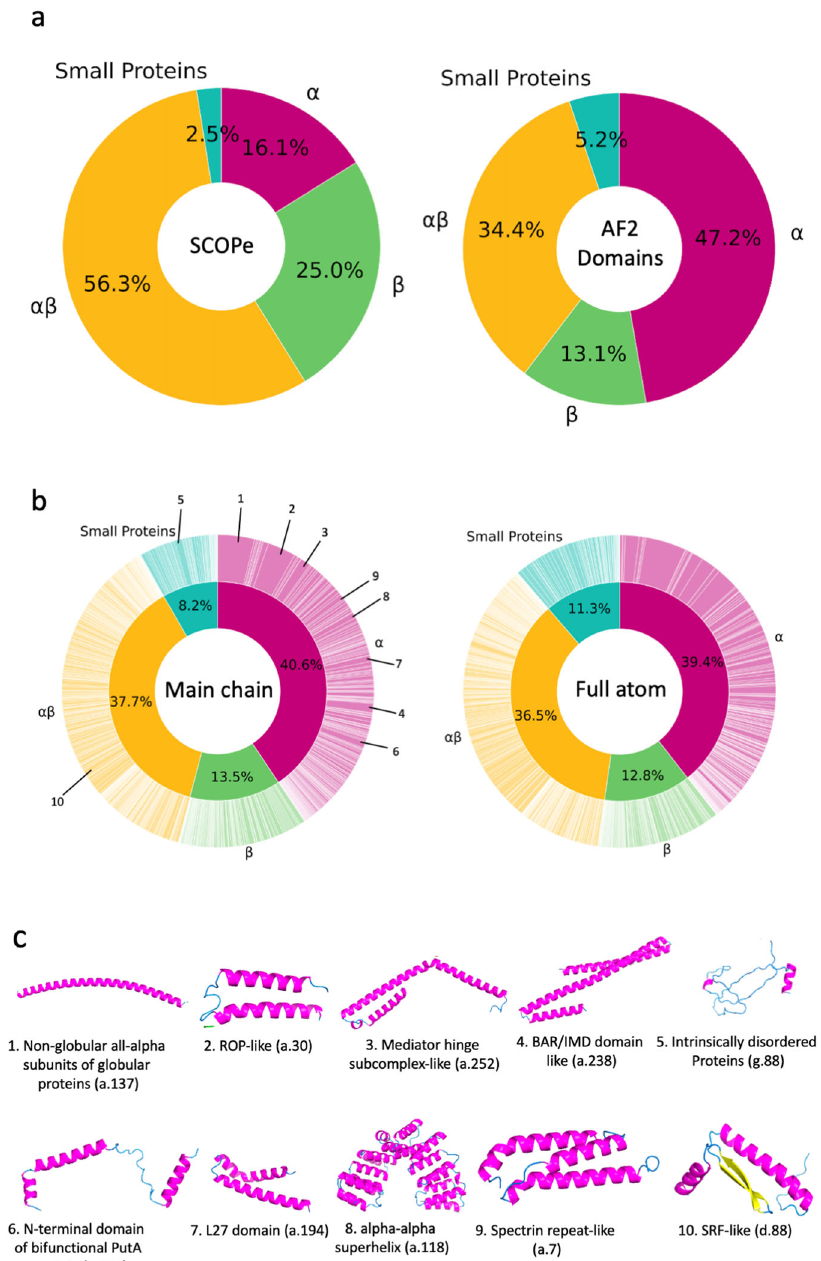
Fig. 2 Distribution of protein secondary structure classes and fold classes of con fi dent domains of AlphaFold2 models. a The secondary structure classes were assigned to SCOPe domains and domains of high con fi dence in AlphaFold2 models. Four classes were considered, α , β , αβ , and small proteins. Left, SCOPe (232,630 domains); right, domains of high con fi dence in AlphaFold2 models. (508,787 domains). The classi fi cation was performed using a bagged SVM ensemble (see Methods). SCOPe domains (left) were also classi fi ed with the SVM ensemble to be able to compare with the results on AlphaFold2 domains (right). b Fold classi fi cation of the AlphaFold2 structure domains of high con fi dence. The classi fi cation was performed with the deep neural networks that were trained on the fold assignment provided in SCOPe (see Methods). The outer wheel indicates the fraction of each fold. Folds were ordered according to SCOPe IDs. Left, the fold distribution of AlphaFold2 domains using the deep network trained on 3DZDs of full atom domain structure surface. The inner wheel shows the fraction of secondary structure classes. Since this classi fi cation was based on the fold assignment, the fractions are overall consistent but not identical to those shown in panel ( a ). The top 10 most abundant folds are indicated. Right, the fold distribution using the deep network trained on 3DZDs of surface shapes with main-chain atoms. c The 10 most abundant folds among AlphaFold2 domains. The fraction of each fold is indicated in the wheel diagram on the left in panel b. For each fold, an example of AlphaFold domains is shown. (1) Non-globular all-alpha subunits of globular proteins (a.137). Example shown is A0A1D6E4Z3_F1, residue 823-895 ( maize ). (2) ROP-like (a.30): A0A1D6MV33_F1, residue 758-815 ( maize ). (3) Mediator hinge subcomplex-like (a.252). Q4DL50_F1, residue 384-495 ( T. cruzi ). (4) BAR/IMD domain-like (a.238). Q8LE58_F1, residue 2-133 ( Arabidopsis ). (5) Intrinsically disordered proteins (g.88).